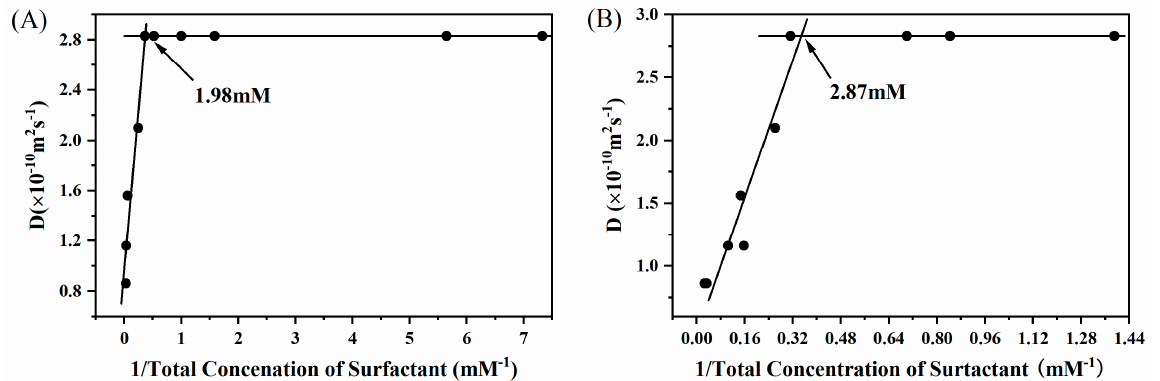
Figure 5. For α SDS = 0.5 ( A ) and 0.2 ( B ), variations of diffusion coefficients of the mixed micelles as a function of the reciprocal of C T .